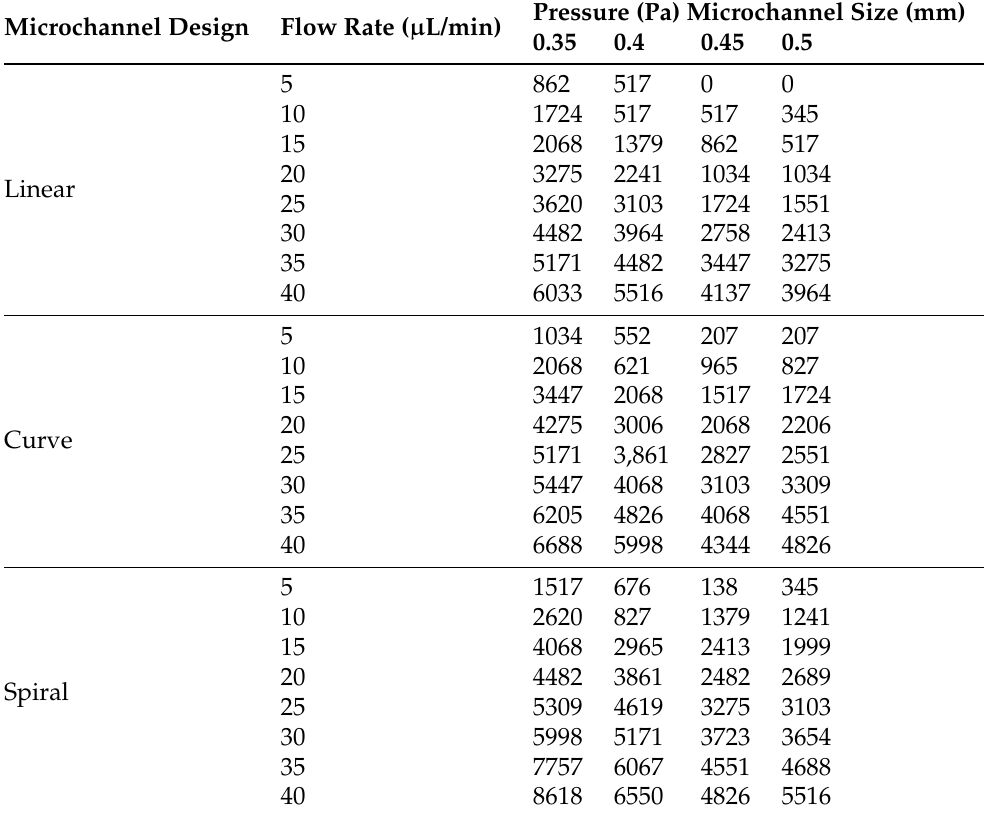
Table 4. Pressure developed in microchannels vs. flow rate. The cells highlighted in red indicate the pressure at which the microchannels started to